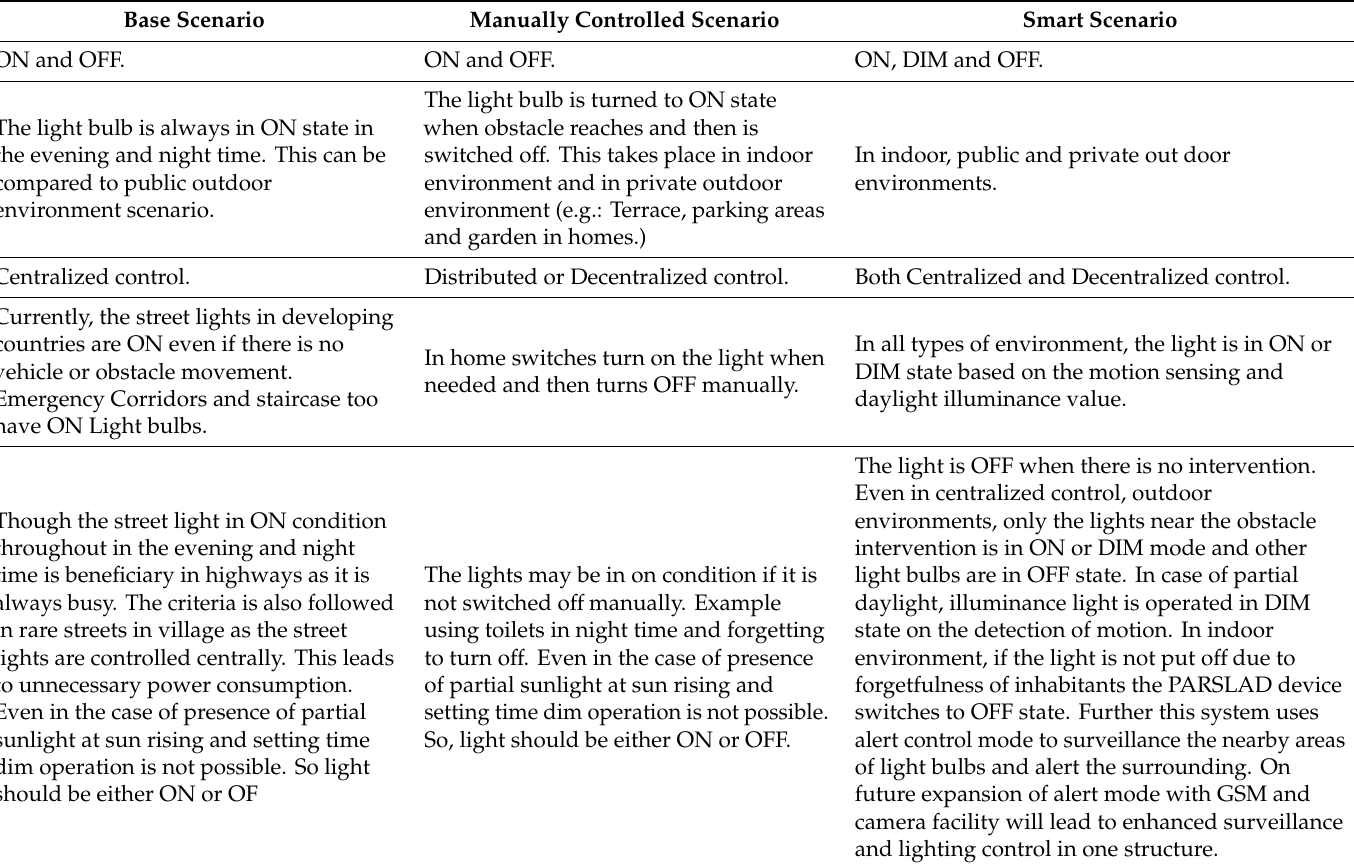
Table 8. Explanation of the three